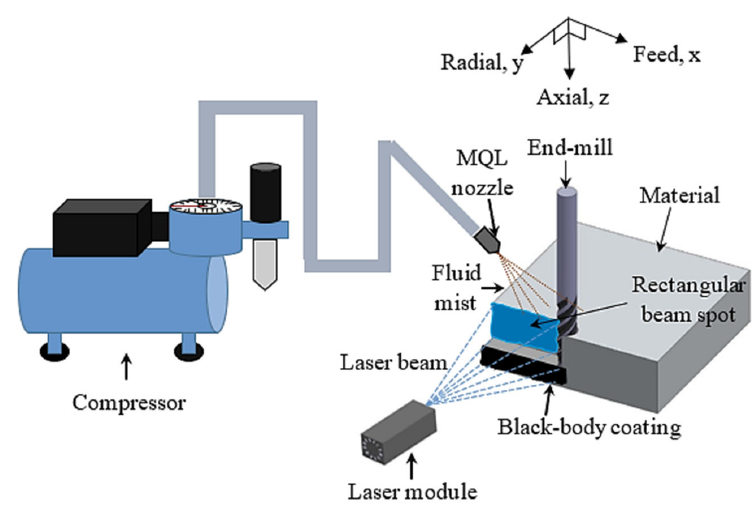
Figure 1. Schematic diagram of the experimental setup.